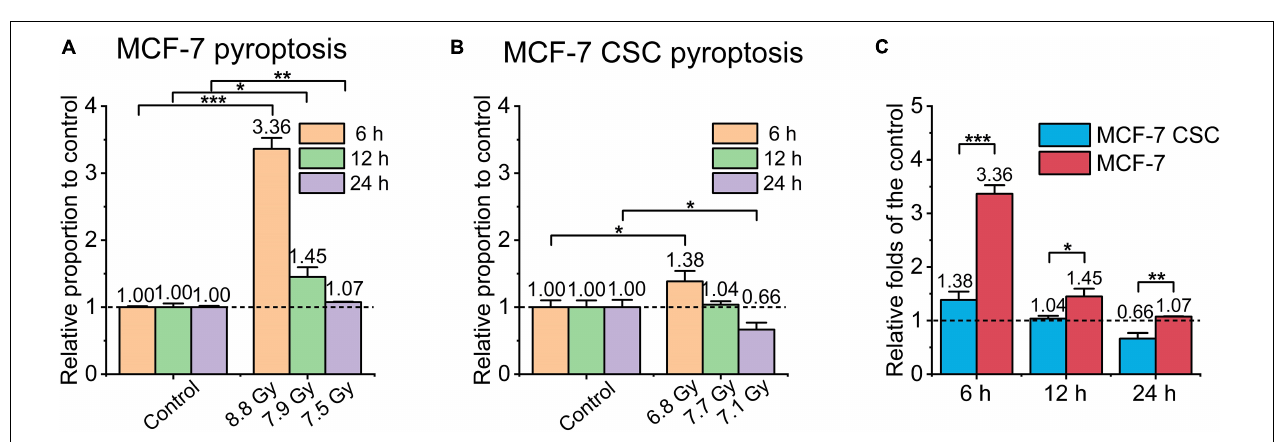
FIGURE 3 | Necrosis of irradiated MCF-7 cells and MCF-7 CSCs. (A–D) Representative images of control groups, irradiated MCF-7 cells and MCF-7 CSCs at 6 h which were stained with annexin V and PI. Necrosis cells were marked with white circles. Scale bars: 100 µ m. (E,F) Compared with the relative controls, the increasement of the necrosis proportion for irradiated groups at 6, 12, and 24 h. (G) The increasement of the necrosis proportion between irradiated MCF-7 cells and MCF-7 CSCs. * P < 0.05; ** P < 0.01; *** P < 0.001.